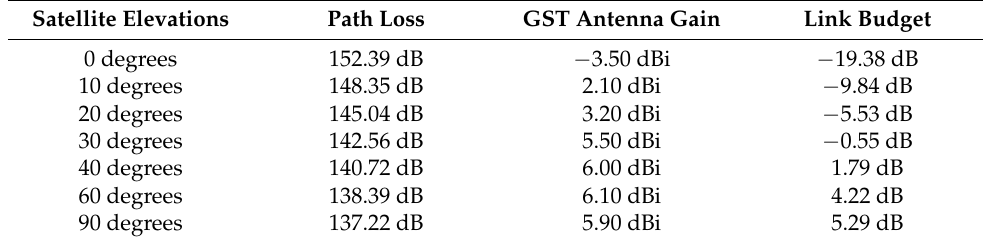
Table 5. Link budget calculations for different